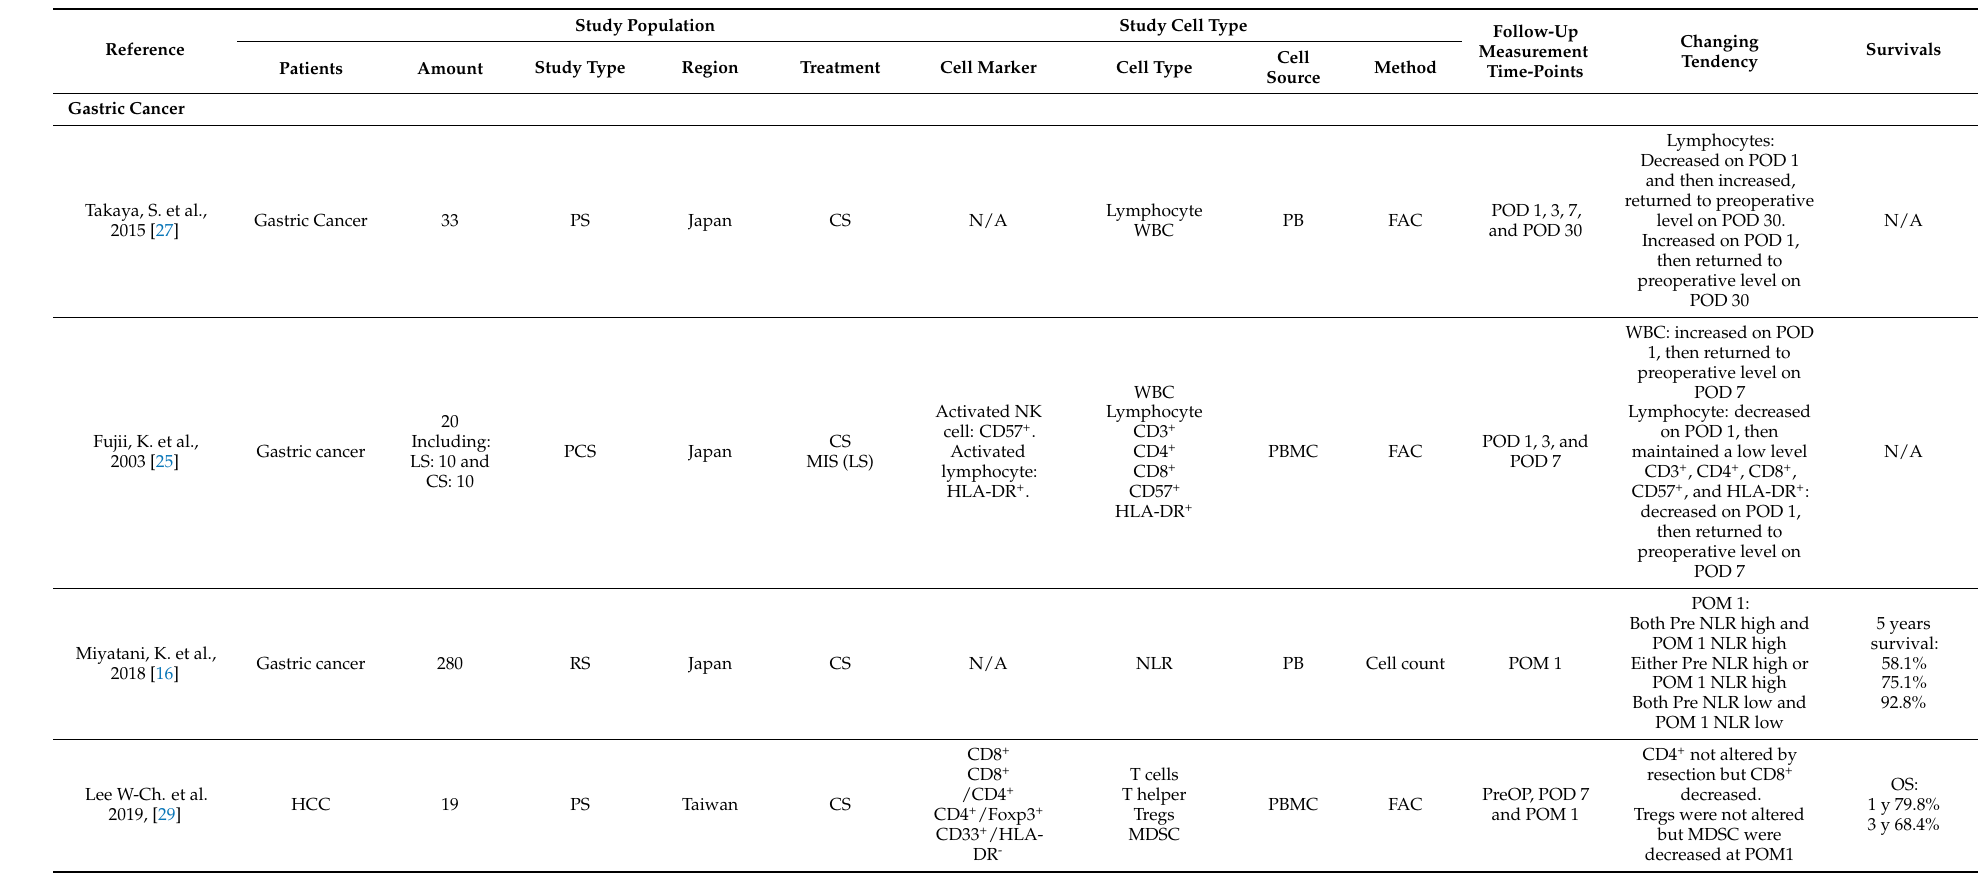
Table 1. Summary of included studies. The studies are grouped by following hierarchy: cancer type, follow-up measurement time-points, studied cell types (WBC, NLR, T cells, etc.), and finally, year of